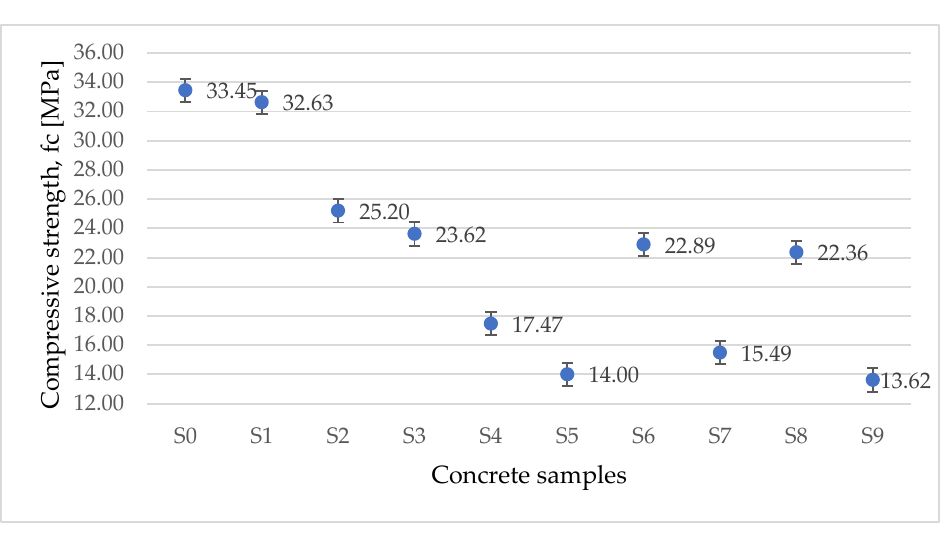
Figure 6. Variation of density for tested concrete samples.